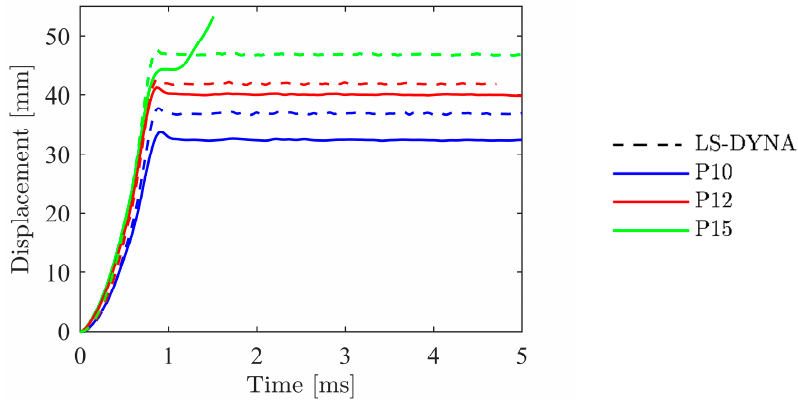
Figure 17. Comparison between experimental and numerical mid-point displacements for aluminium skins only.